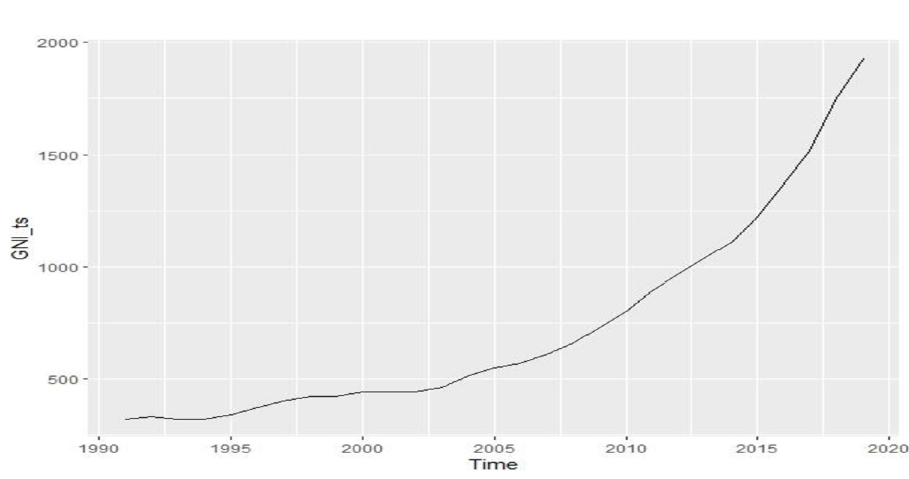
Fig 3. Comparison graphs of factors between Bangladesh & other highly developed nations.